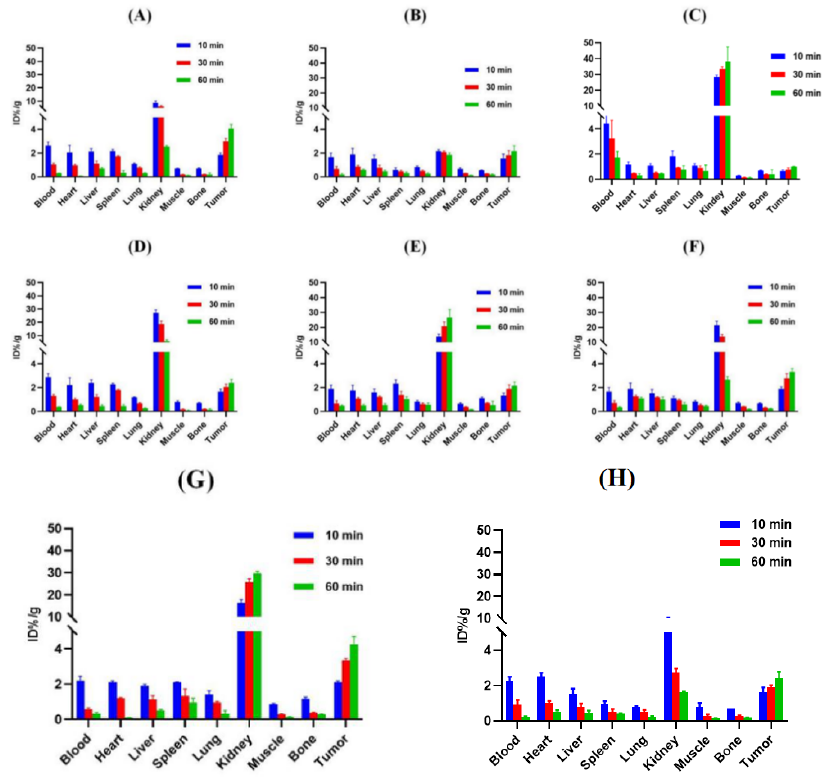
Figure 5. Uptake values for ex vivo tissues of ( A ) [ 68 Ga]Ga-PSMA-Q, ( B ) [ 68 Ga]Ga-PSMA-4PY, ( C ) [ 68 Ga]Ga-PSMA-P, ( D ) [ 68 Ga]Ga-PSMA-Q-1, ( E ) [ 68 Ga]Ga-PSMA-Q-2, ( F ) [ 68 Ga]Ga-PSMA-Q-3, ( G )